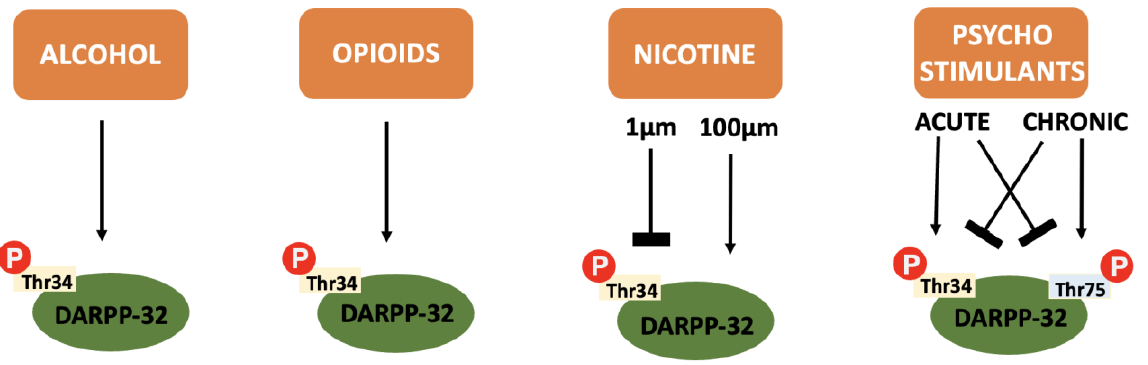
Figure 4. A summary of the effect of various drugs of abuse on DARPP-32 phosphorylation: Alcohol, opioids and cannabinoids cause an increase in Thr 34 independent of concentration or repeated administration. Nicotine causes inhibition of Thr 34 phosphorylation at low concentrations and increases Thr 34 phosphorylation at higher concentrations. Psychostimulants cause increased Thr 34 phosphorylation and decreased Thr 75 phosphorylation after acute administration and the reverse after chronic administration.